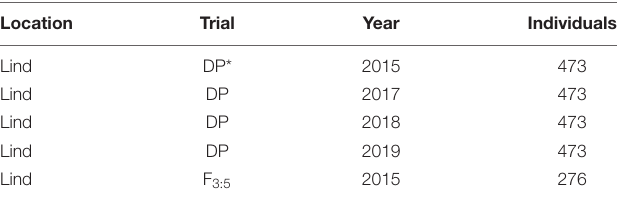
*DP: quality association mapping diversity